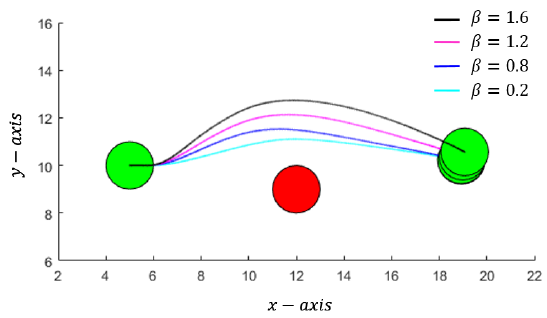
Figure 6. It shows the paths taken by a double integrator to reach the goal at (20,10) from its initial position at (5,10), for selected β , while avoiding collision with a static passive agent at (12,9). The control parameter η was set to